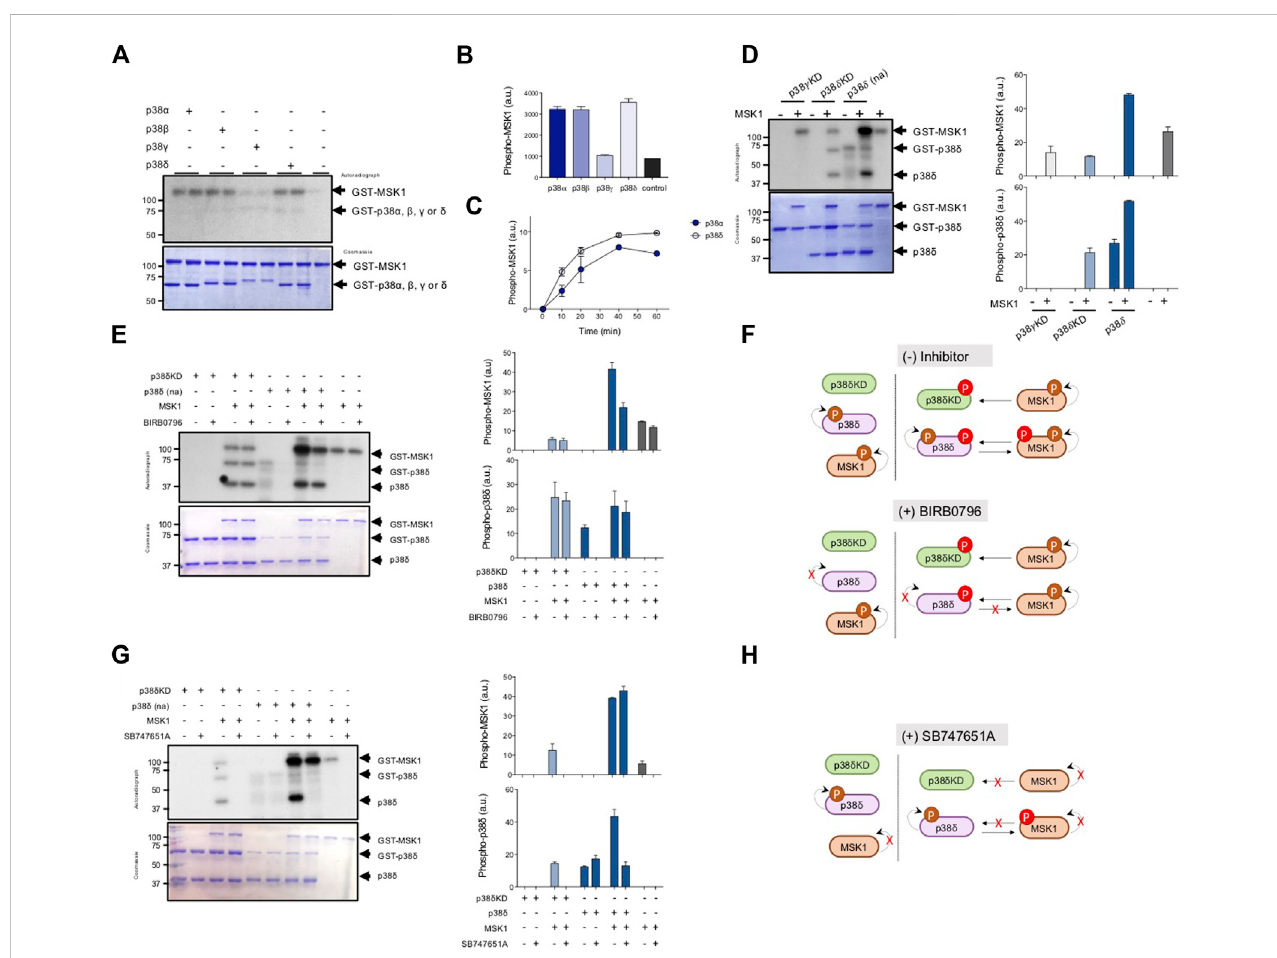
FIGURE 3 MSK1isphosphorylatedbyp38 δ . (A) RecombinantGST-MSK1(1 µM)wasincubatedwithactiverecombinantp38 α ,p38 β ,p38 γ orp38 δ for60 minat30 ° C inaphosphorylationreactionmixcontainingMg-[ γ 32 P]-ATP,asdescribedinmaterialsandmethods.Theactivityofrecombinantp38 α ,p38 β ,p38 γ orp38 δ was matched using MBP as substrate and 0.5 U/mL were used in the assay. Reaction was stopped with SDS-sample buffer. Samples were resolved in